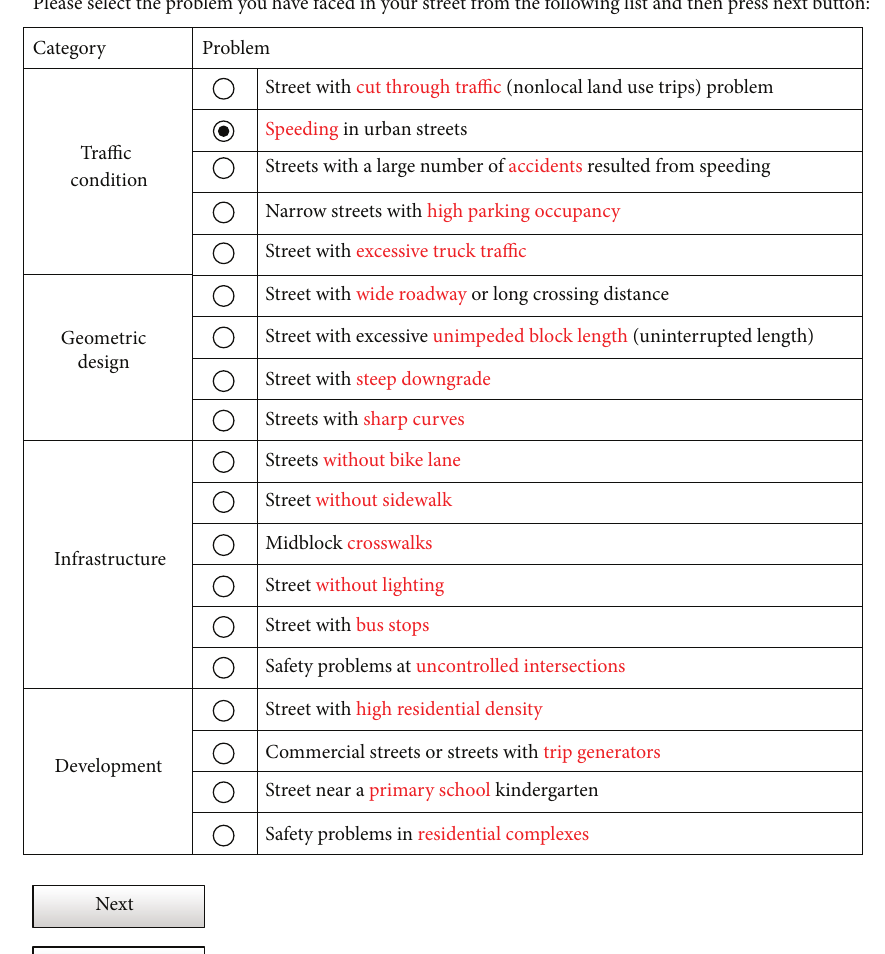
Figure 6: A screenshot of the problems and solutions